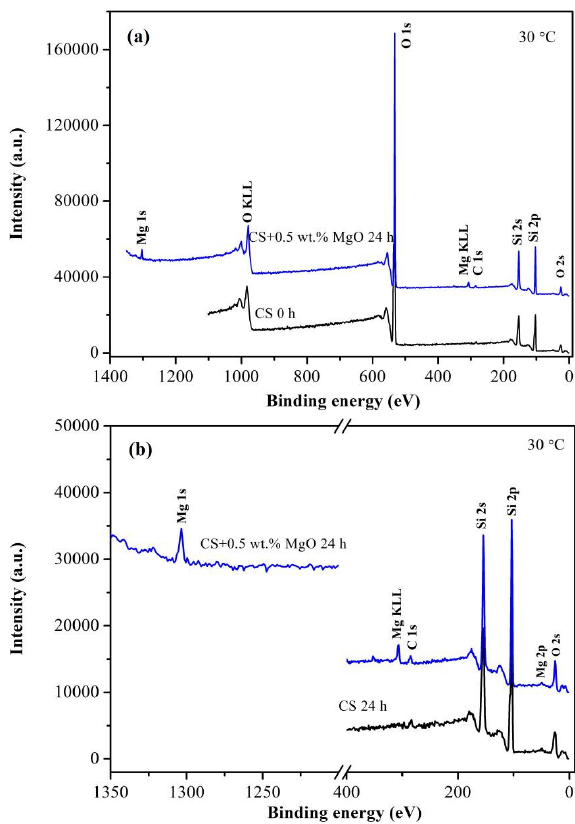
Figure 3: XPS spectra of colloidal silica with and without MgO af- ter curing for 24 hours at 30 ∘ C (a), and (b) is a local amplification spectrum of (a).